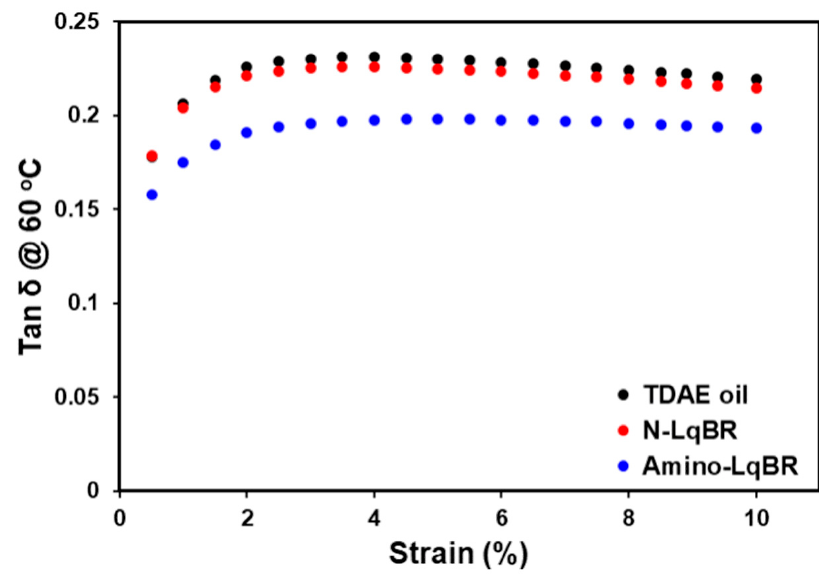
Figure 11. Tan δ curves of vulcanizates in the strain sweep test.